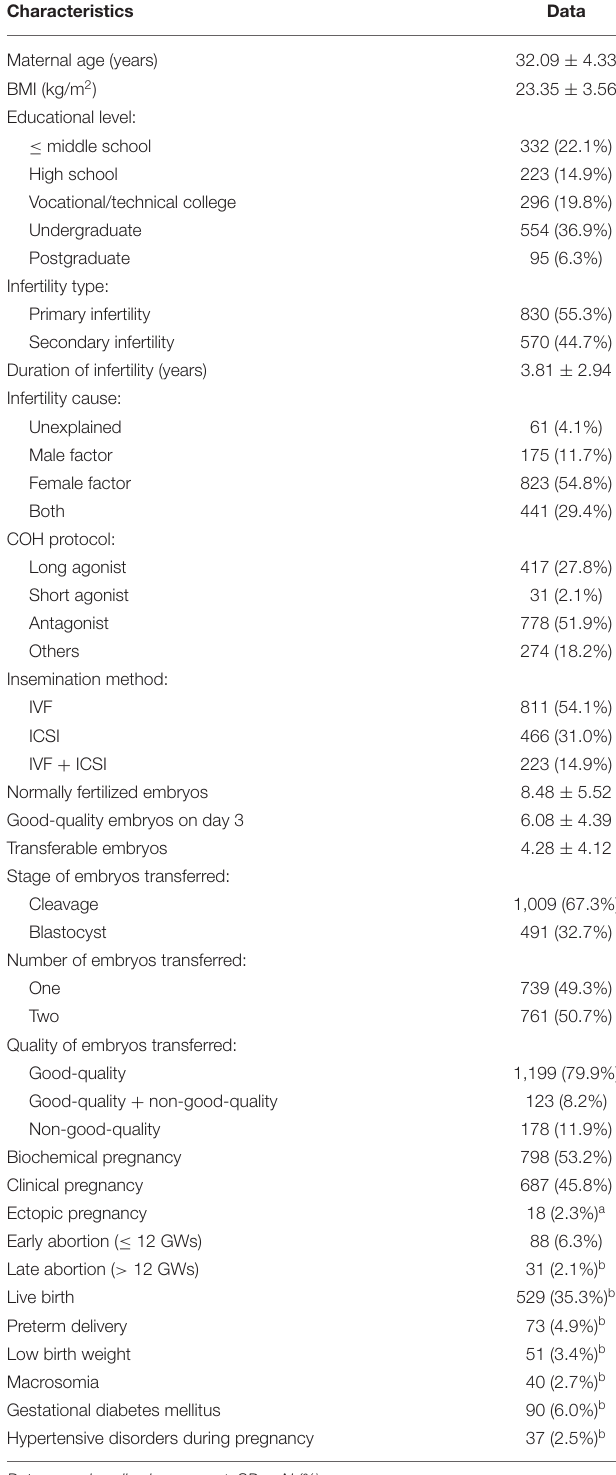
TABLE 1 | Demographic and clinical characteristics of the study population ( N =